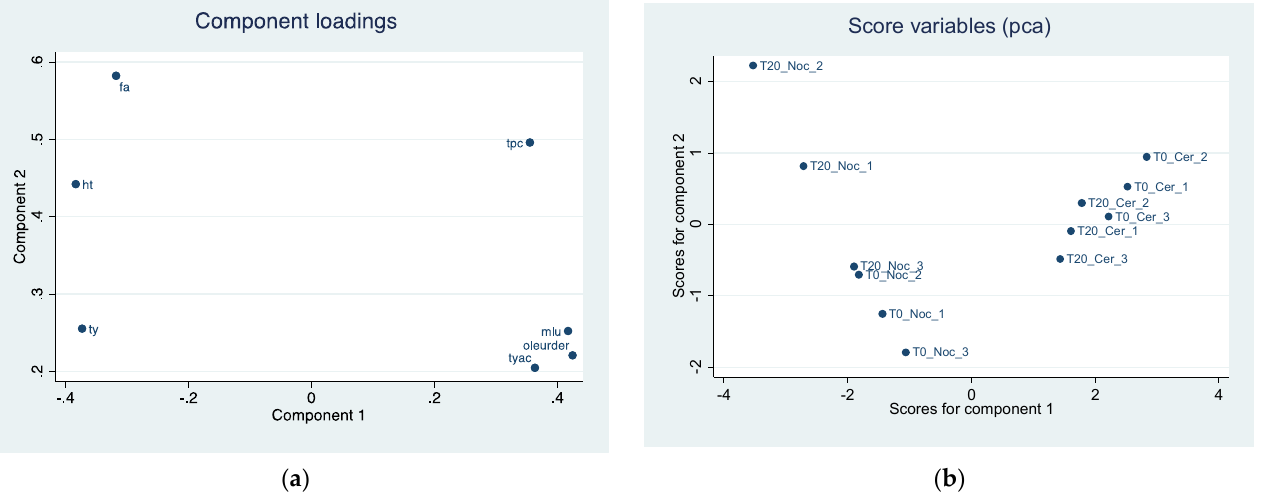
Figure 6. ( a ) Component loadings of biophenols in two EVOO cultivars by different malaxation methods (T0 and T20). First two principal component (Component 1 x -axis, Component 2 y -axis) analysis (PCA). ( b ) Predicted scores after PCA obtained as linear combination of the observation data by using eigenvector of component 1 ( x -axis) and eigenvector of component 2 ( y -axis).